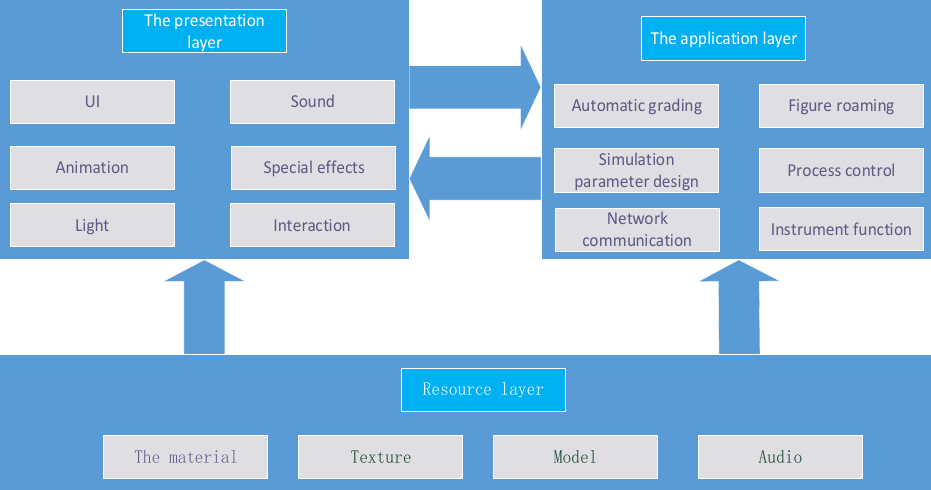
Figure 8. Overall architecture diagram of the 3D simulation module.